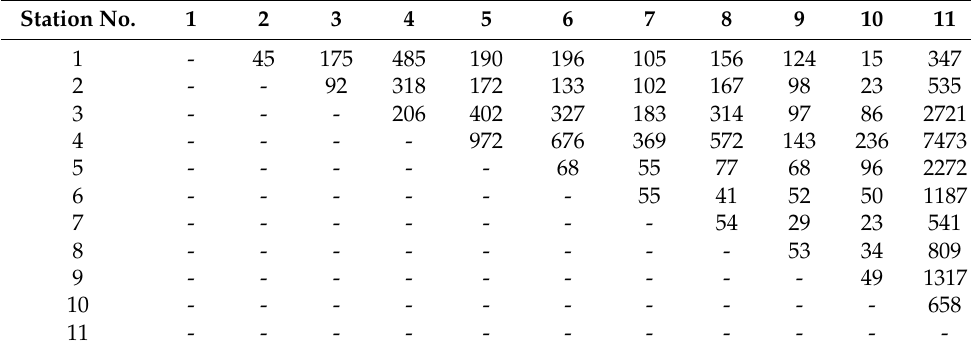
Table 5. Passenger OD matrix for the Jiangjin Line during long-term morning peak hours (unit: persons/h).